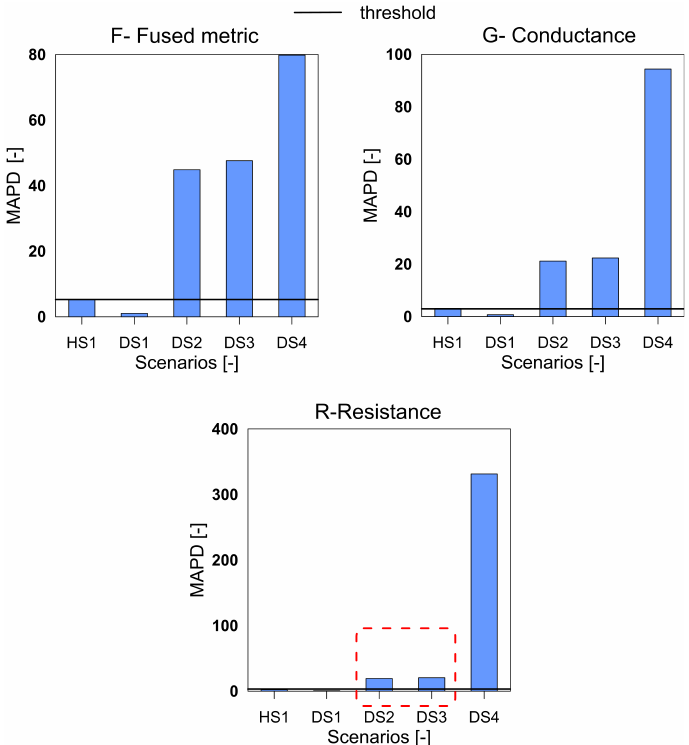
Figure 12. The MAPD index for the variables F, G and R for GFRP